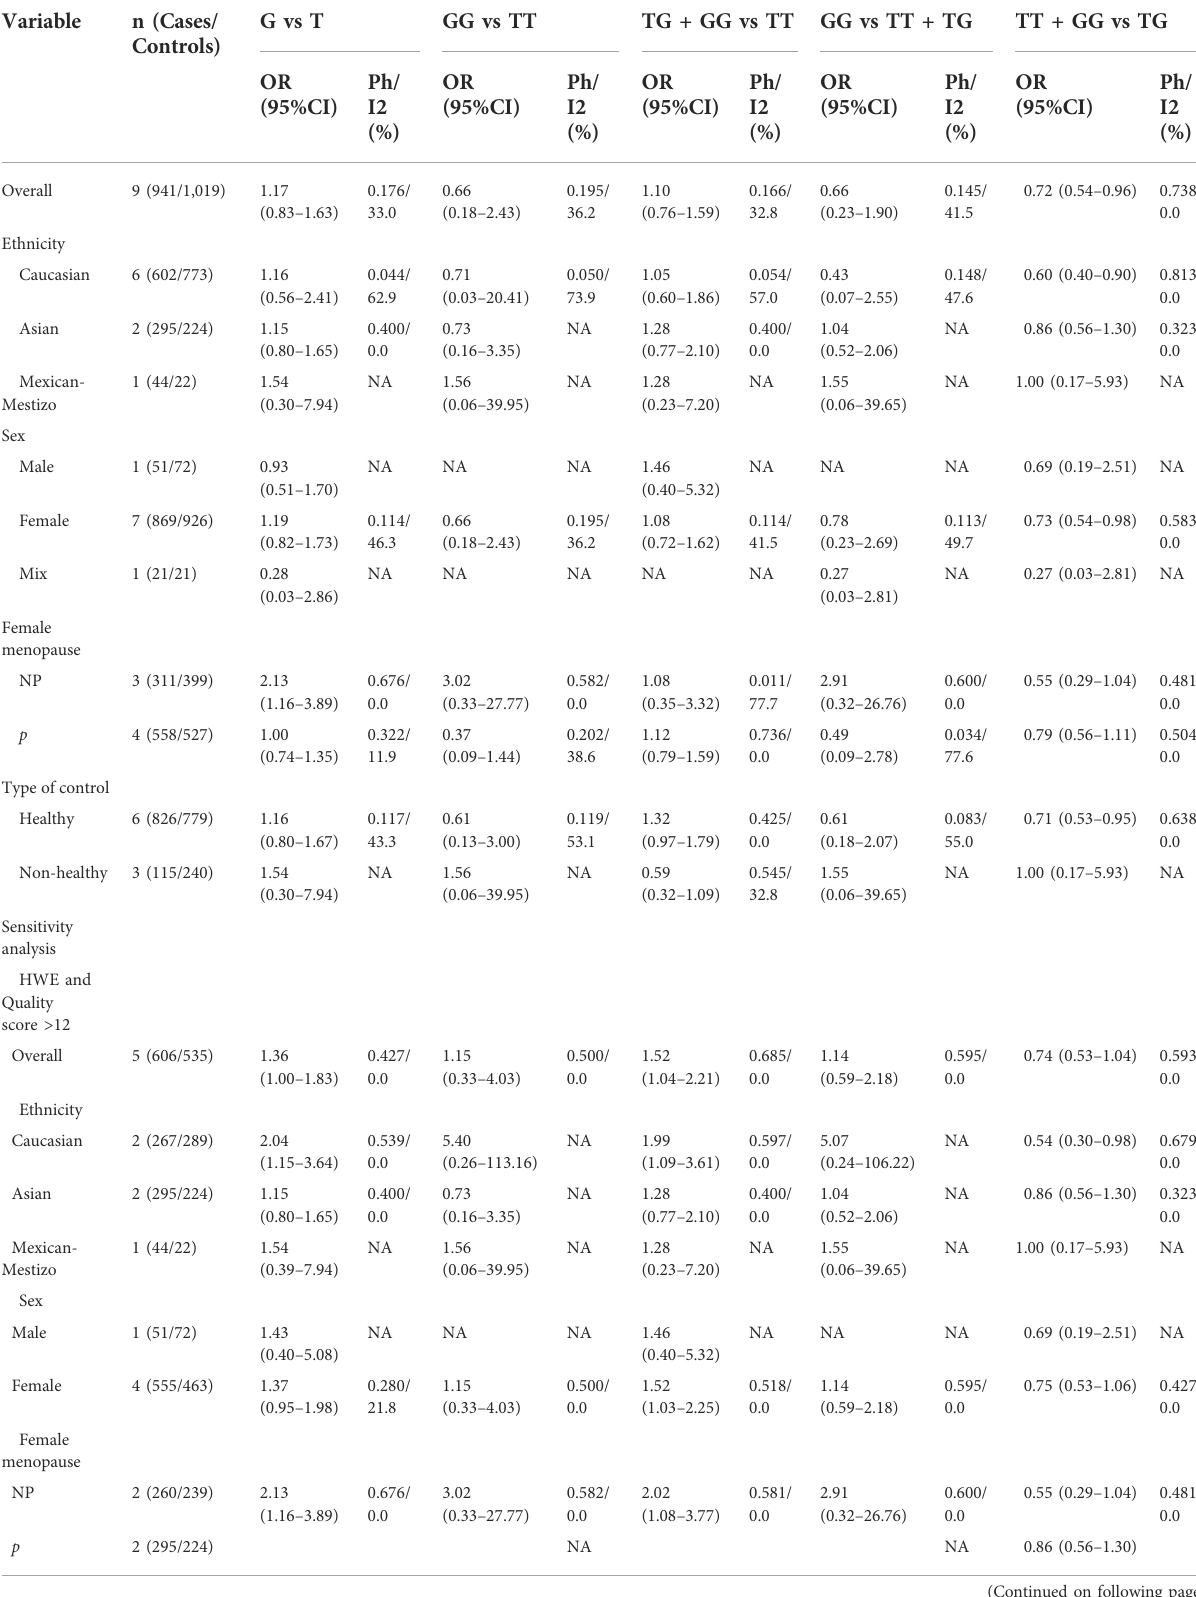
TABLE 2 Meta-analysis of the association of OPG T245G polymorphism with risk of osteoporosis.